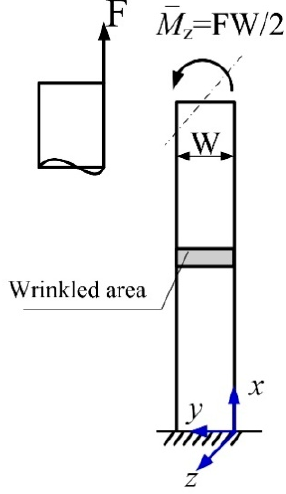
Figure 18. Additional bending moment in an extreme case.